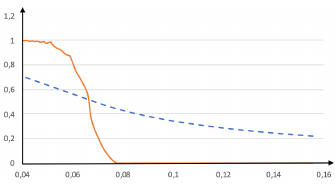
Figure 6. P 2 versus P 3 for the Runge function with α = 2000. Comparison between the statistical frequencies (full) and the probabilistic law (2.7) (dotted). 500 meshes are used for each value of h